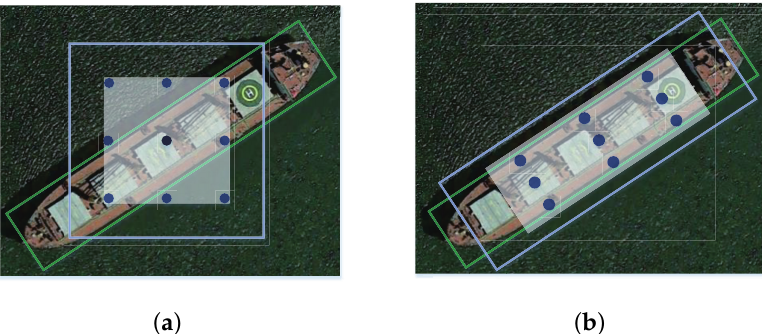
Figure 2. Comparison of receptive fields between ( a ) an axis-aligned neuron and ( b ) an adaptive neuron. The green rectangle represents the boundary of the instance, and the gray rectangle represents the boundary of the receptive